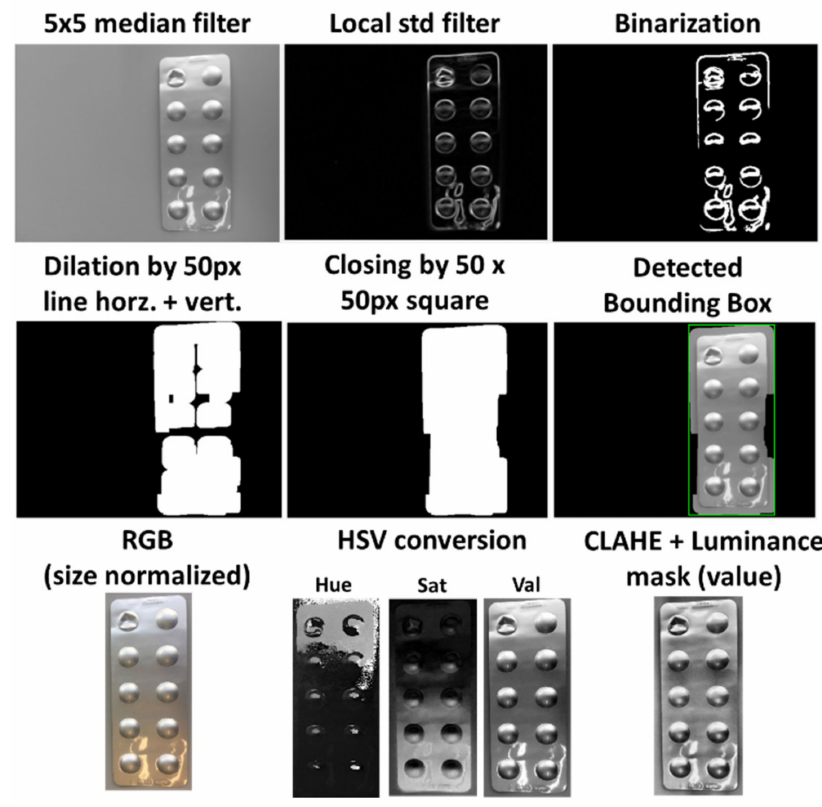
Figure 2. Individual steps of automatic blister detection and image